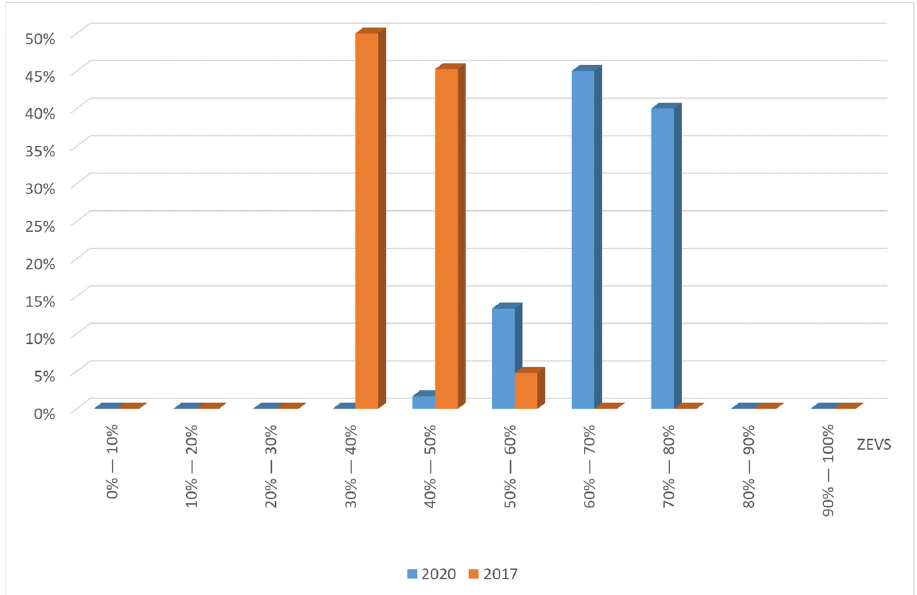
Figure 9. Frequency distribution of the ZEVS values.